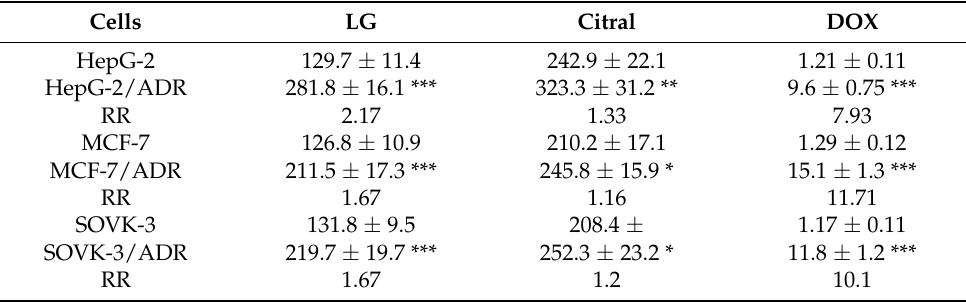
Table 2. IC 50 values ( µ g/mL) of the cytotoxicity assay of sensitive and resistant cell